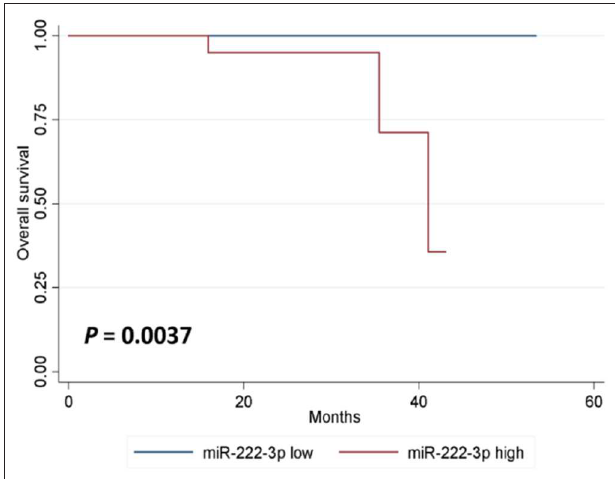
FIGURE 3 | Kaplan-Meier estimates of overall survival according to the expression of serum miR-222-3p.